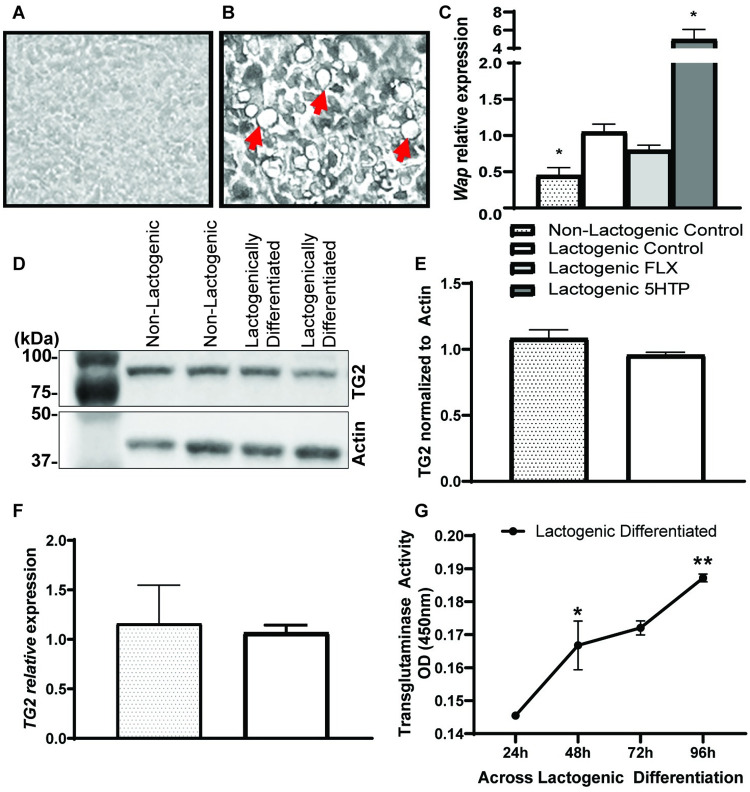
Transglutaminase protein and activity are observed in mouse mammary epithelial cells.A. Brightfield image of non-lactogenic HC11 cells, not treated with prolactin or hydrocortisone B., and lactogenically differentiated HC11 cells show morphological changes in the form of mammosphere production seen by the arrows. C. Whey acidic protein (Wap) gene expression is upregulated when treated with lactogenic hormones and further increased with lactogenic hormones + 5HTP. D. Western blot analysis of transglutaminase 2 (TG2) in lysate of HC11 cells before differentiation (proliferation media) and after differentiation (lactogenic media), quantified in E., show no change in protein expression. TG2 quantification relative to the actin control. F.
TG2 gene expression is unchanged before and after differentiation. G. TG activity significantly increases overtime in the lactogenic differentiated cells. Values are means and bars indicate SEM (n = 3 independent cell cultures). *p<0.05 **p<0.01 ***p<0.001 ****p<0.0001.